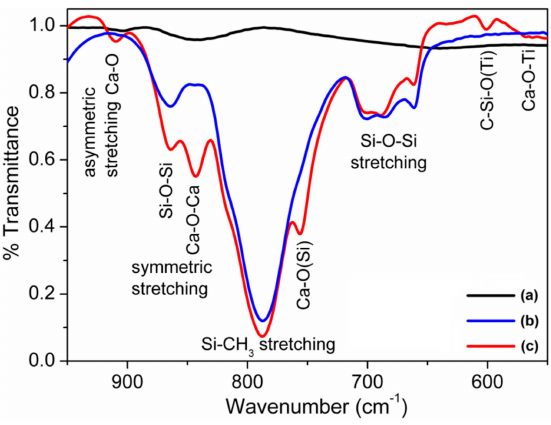
Figure 7. Fourier transforms infrared (FTIR) spectra of the ( a ) ceramic powder sintered at 1050 ˝ C (S1050); ( b ) pristine PDMS film; and ( c ) S1050/PDMS composite film.